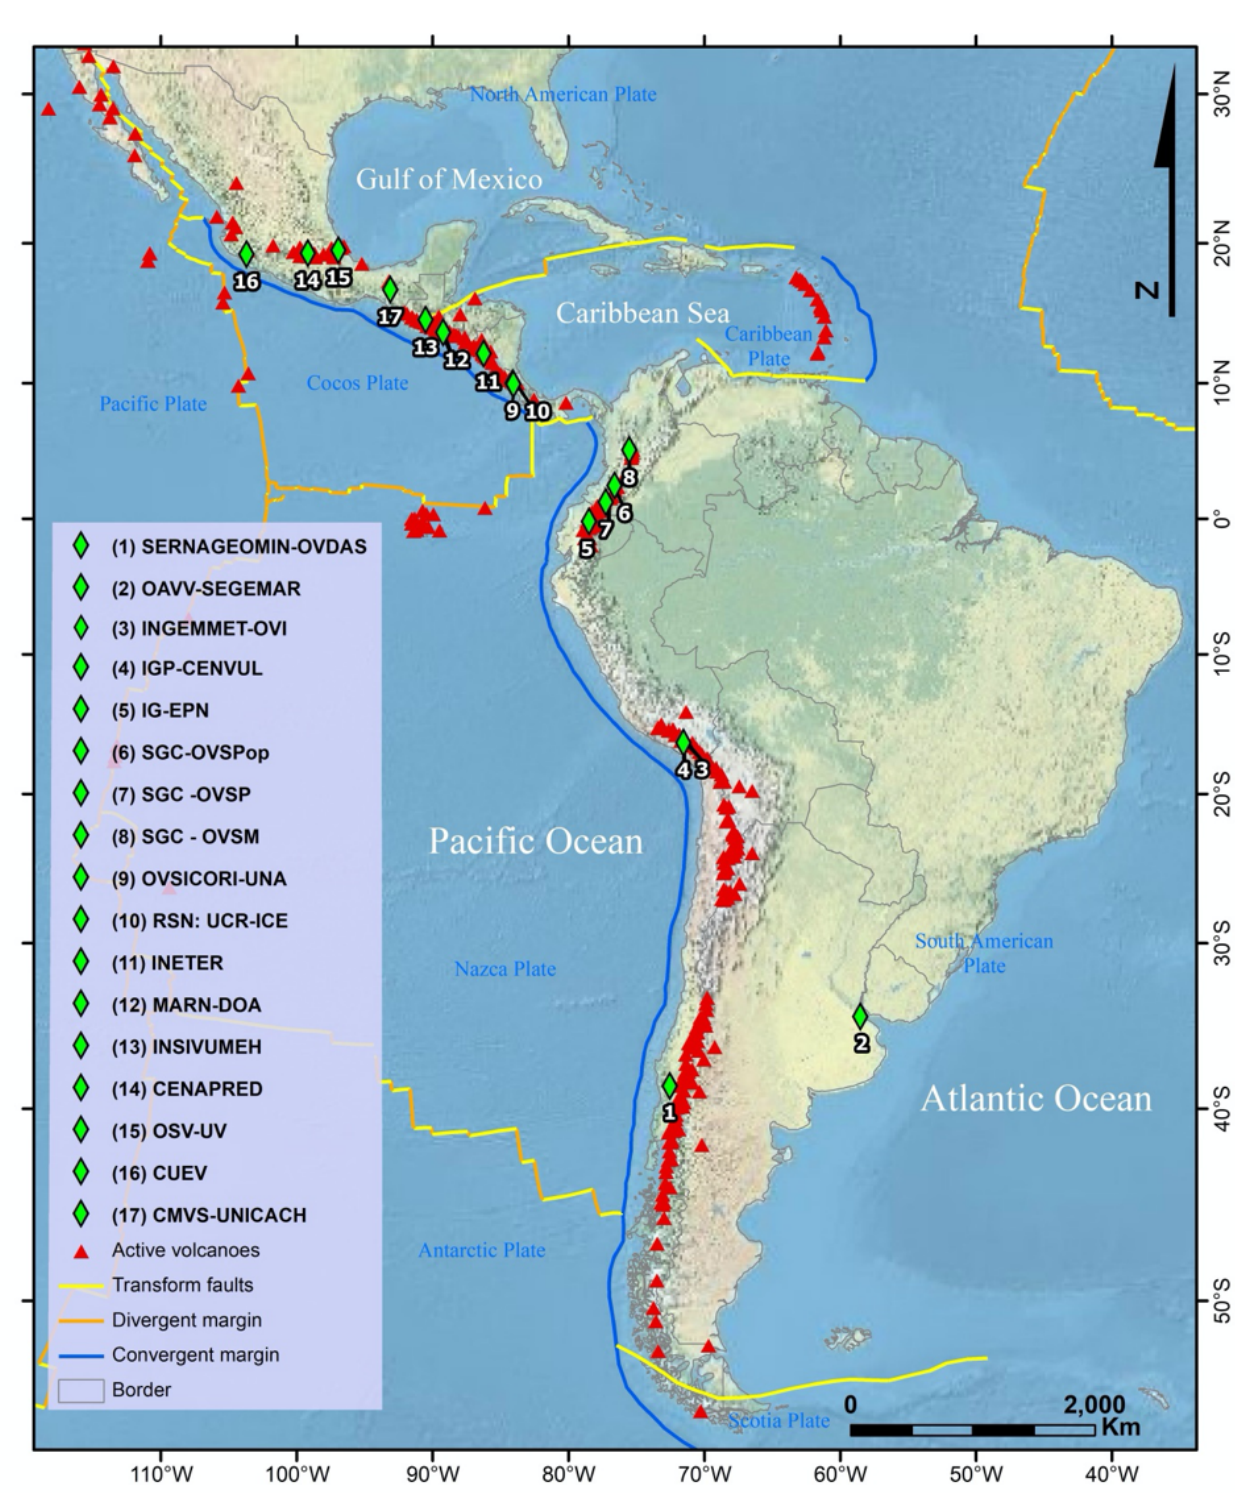
Figure 1: Map showing the active volcanoes (red triangles) and volcano monitoring institutions (green diamonds) in Latin America. A detailed list of these institutions is provided in Table 1. Although represented in the map, active volcanoes from the Caribbean volcanic arc (upper right cluster of volcanoes) are not included in the Latin American region as defined here † . The map in this figure is sourced from Esri®.